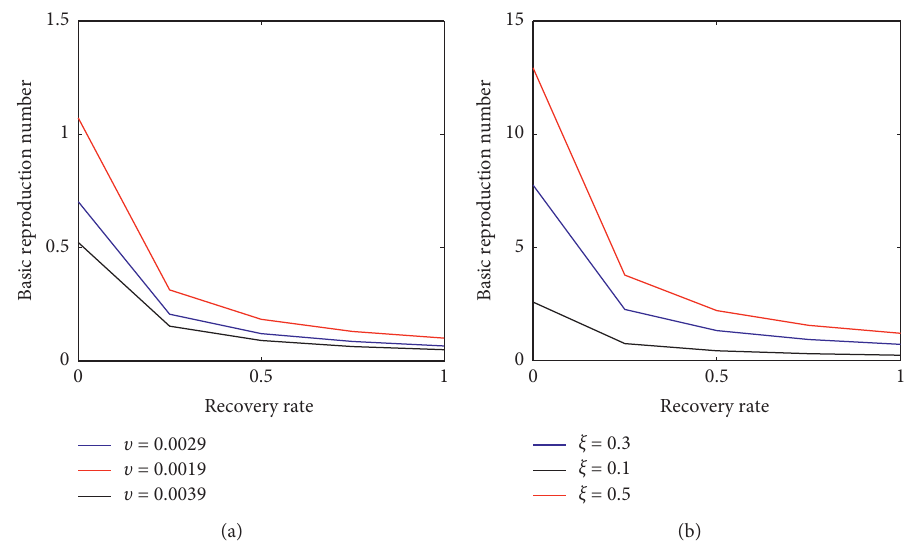
Figure 6: (a) Effect of varying the rate at which unaware susceptibles become aware of antibiotic resistance in treating the disease on the control reproduction number, with parameter value ξ � 0 . 02, and other parameter values remain as in Table 1. (b) The effect of varying loss of information about disease by aware susceptibles on the reproduction number and recovery rate, with the rest of parameter values unchanged as in Table